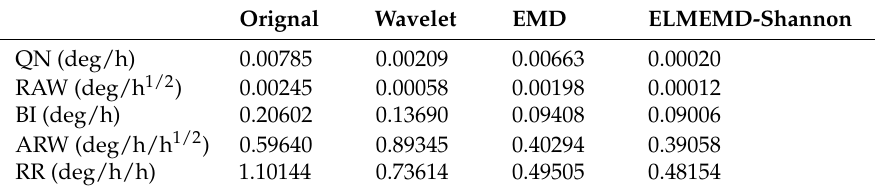
Table 2. Errors of the y -axis gyro signal.